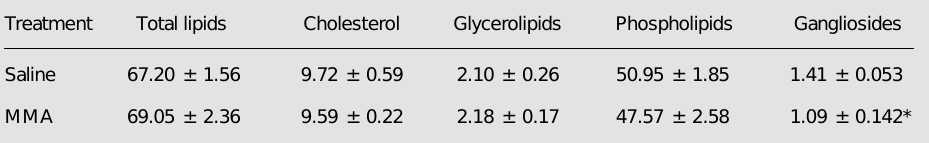
Table 1 - Effect of chronic administration of methylmalonic acid (MMA) on the concentration of total lipids, cholesterol, glycerolipids, phospholipids and ganglioside N-acetylneuraminic acid in rat cerebrum. Data are reported as means ± SD for 9-11 rats and are expressed as mg/g cerebrum. *P<0.05 compared with the saline group (Student t